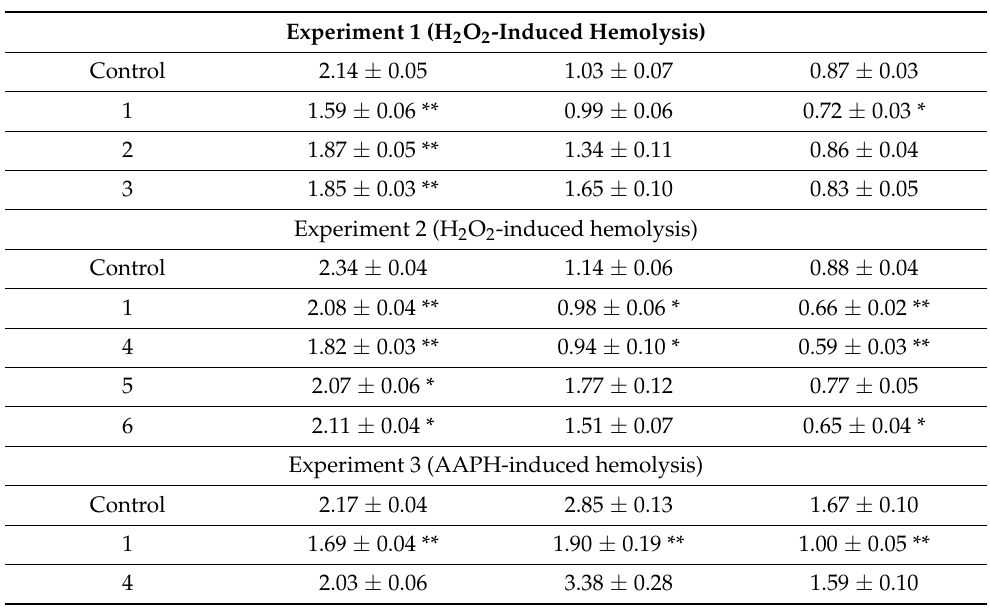
Table 1. The influence of compounds 1–6 (100 µ M) on the parameters of H 2 O 2 and AAPH-induced